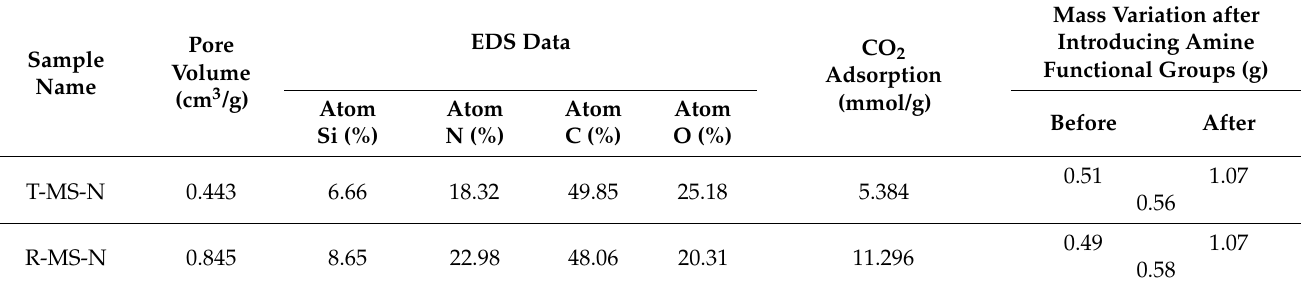
Figure 6. CO 2 adsorption performance of T-MS-N and R-MS-N. Table 2. Pore volume, EDS, and CO 2 adsorption results of T-MS-N and R-MS-N.